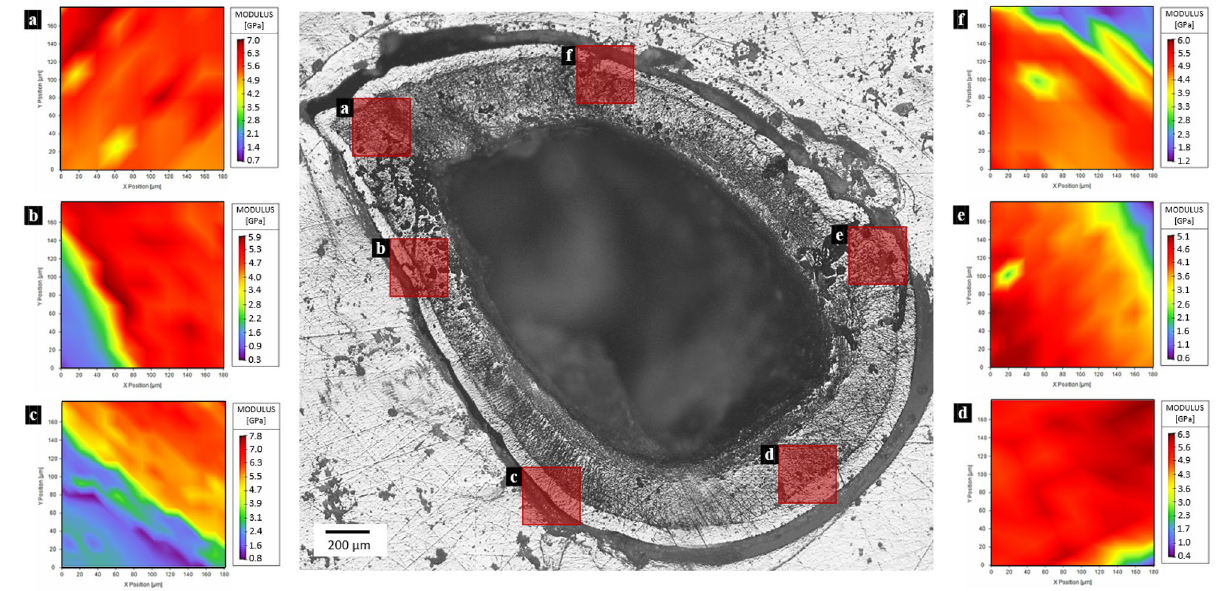
Figure 4. Map of the Young’s modulus of the spider fang in the transversal section on the base. Images generated with the support of Nanoblitz 3d, Nanomechanics Inc.